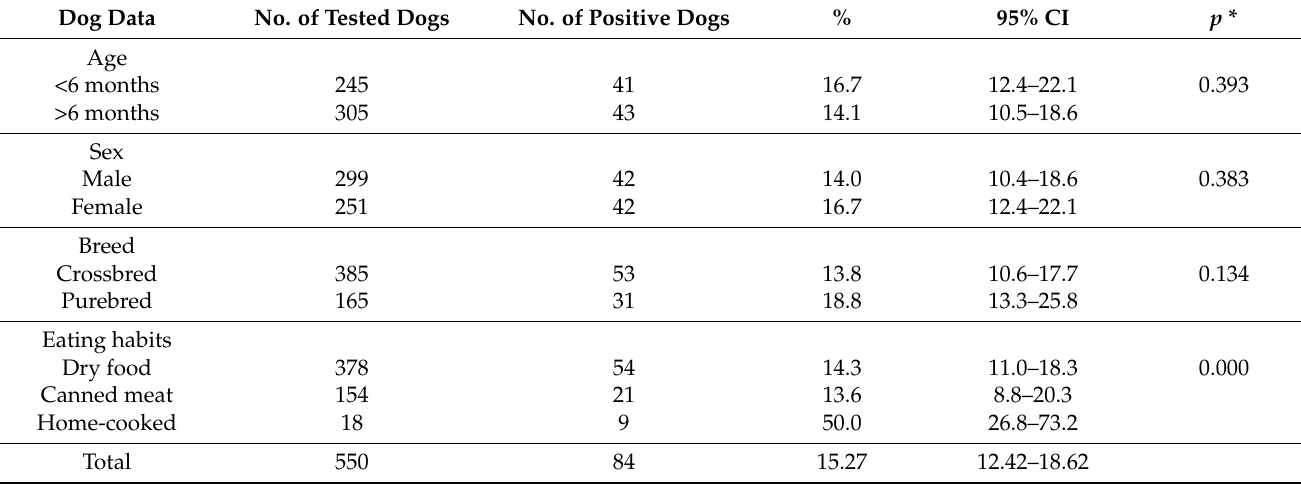
Table 1. Dog data and positivity for Campylobacter jejuni .